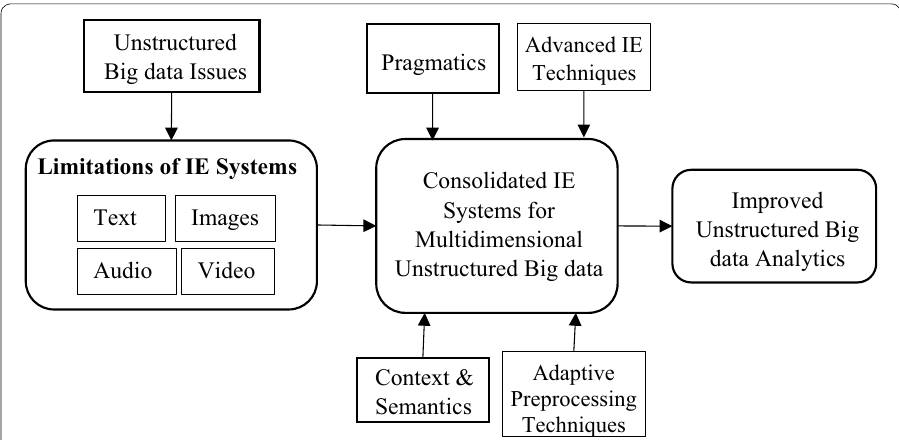
Fig. 5 Consolidated IE systems for multidimensional unstructured big